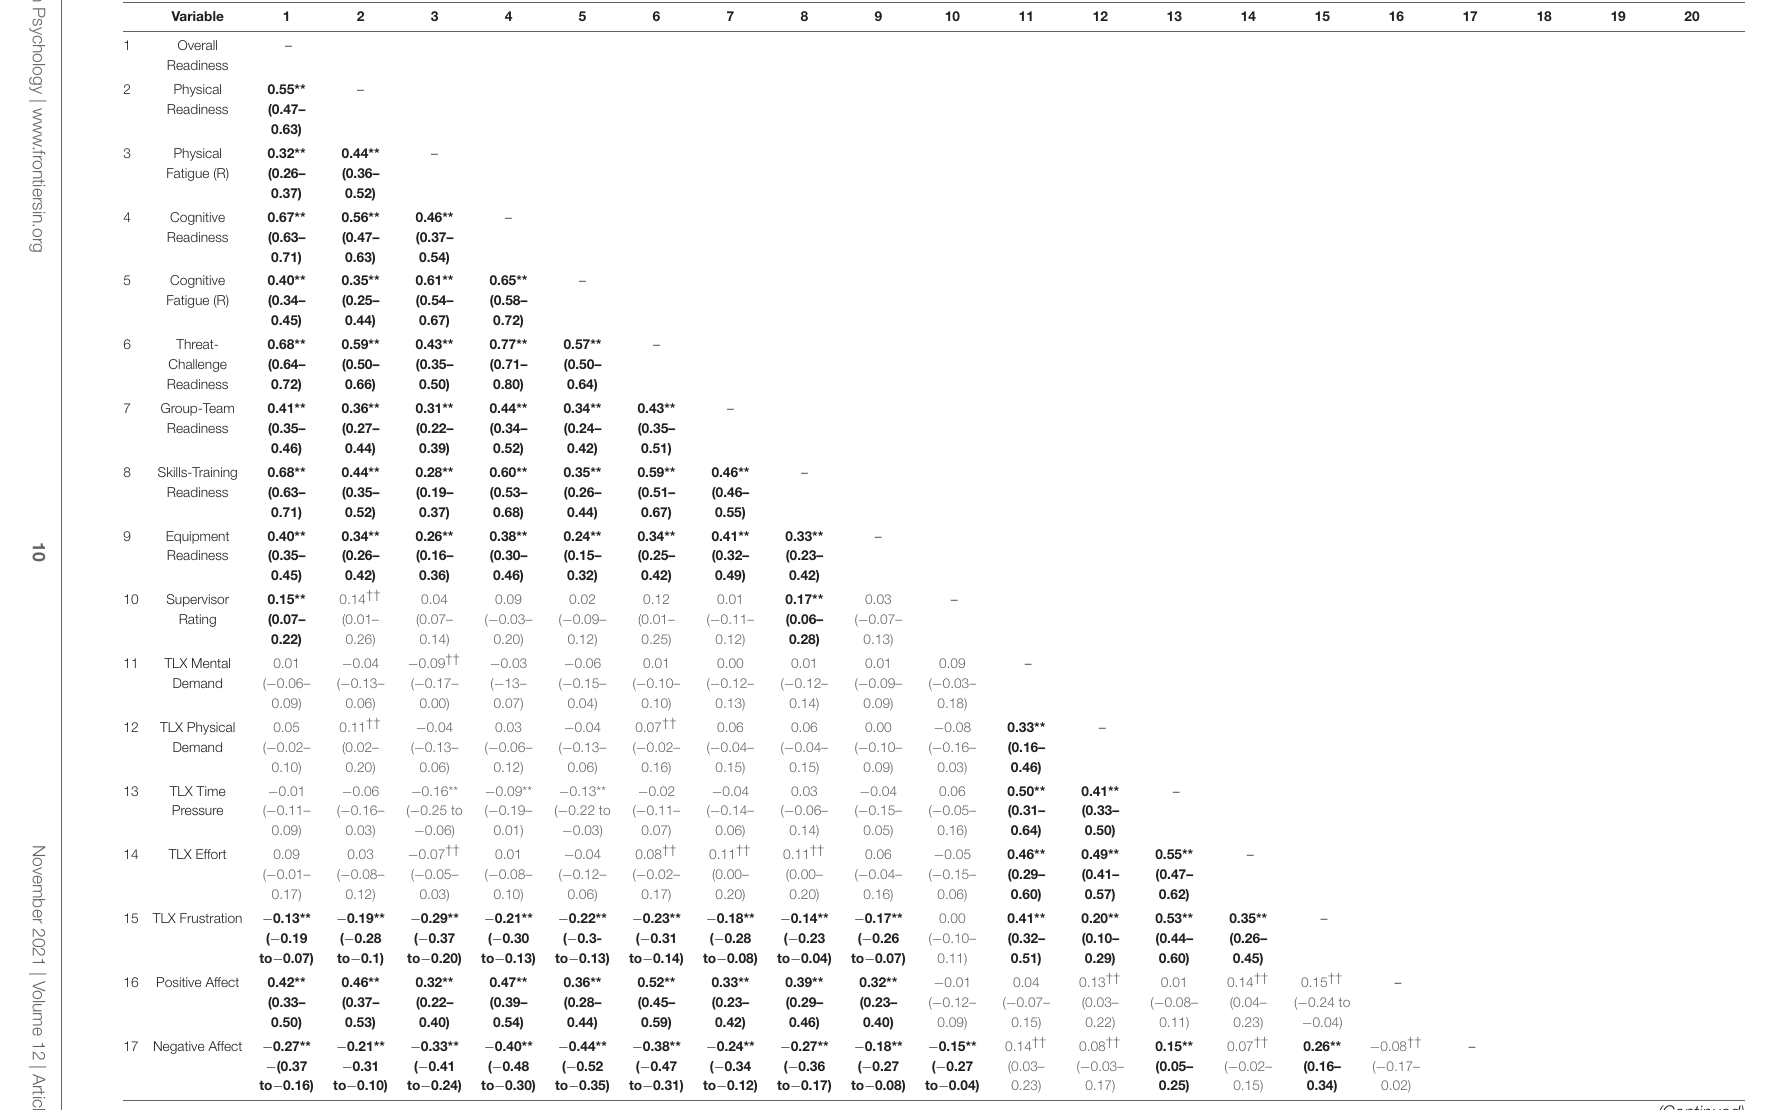
TABLE 4 | Correlation table for concurrent and discriminant validity of study 2 – acute and short-term correlates.